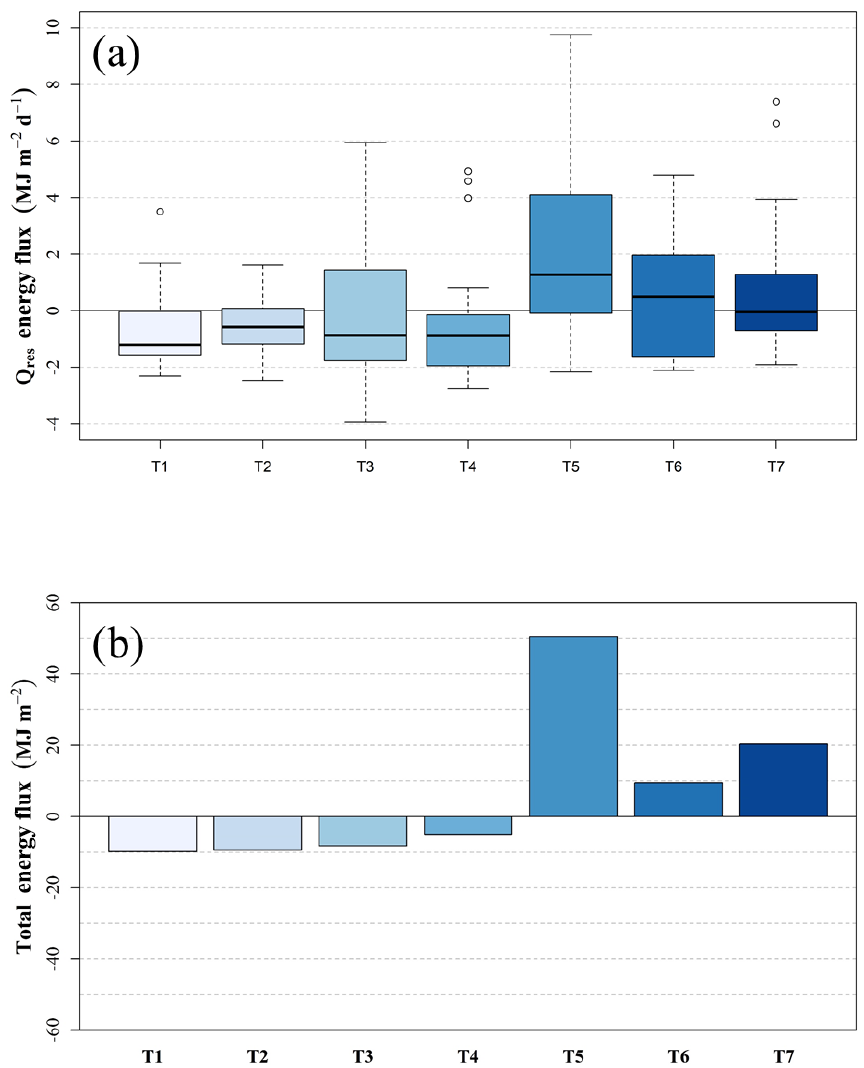
Figure 6. Box plot of daily residual snowpack energy fluxes (a) and bar chart of total summed energy flux (b) by synoptic type for the 2016 and 2017